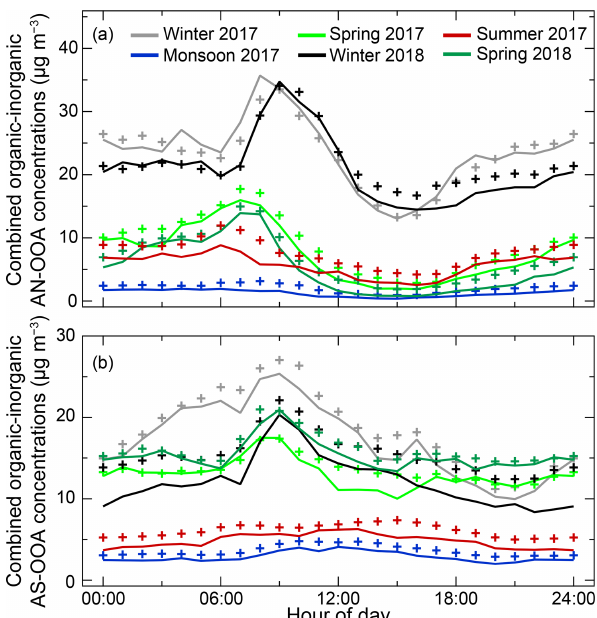
Figure 5. Seasonally representative diurnal mean ( + ) and me- dian (lines) concentrations of (a) AN-OOA and (b) AS-OOA from organic–inorganic combined PMF analysis. Compared to AN- OOA, AS-OOA concentrations remain relatively stable throughout the day, particularly in warmer